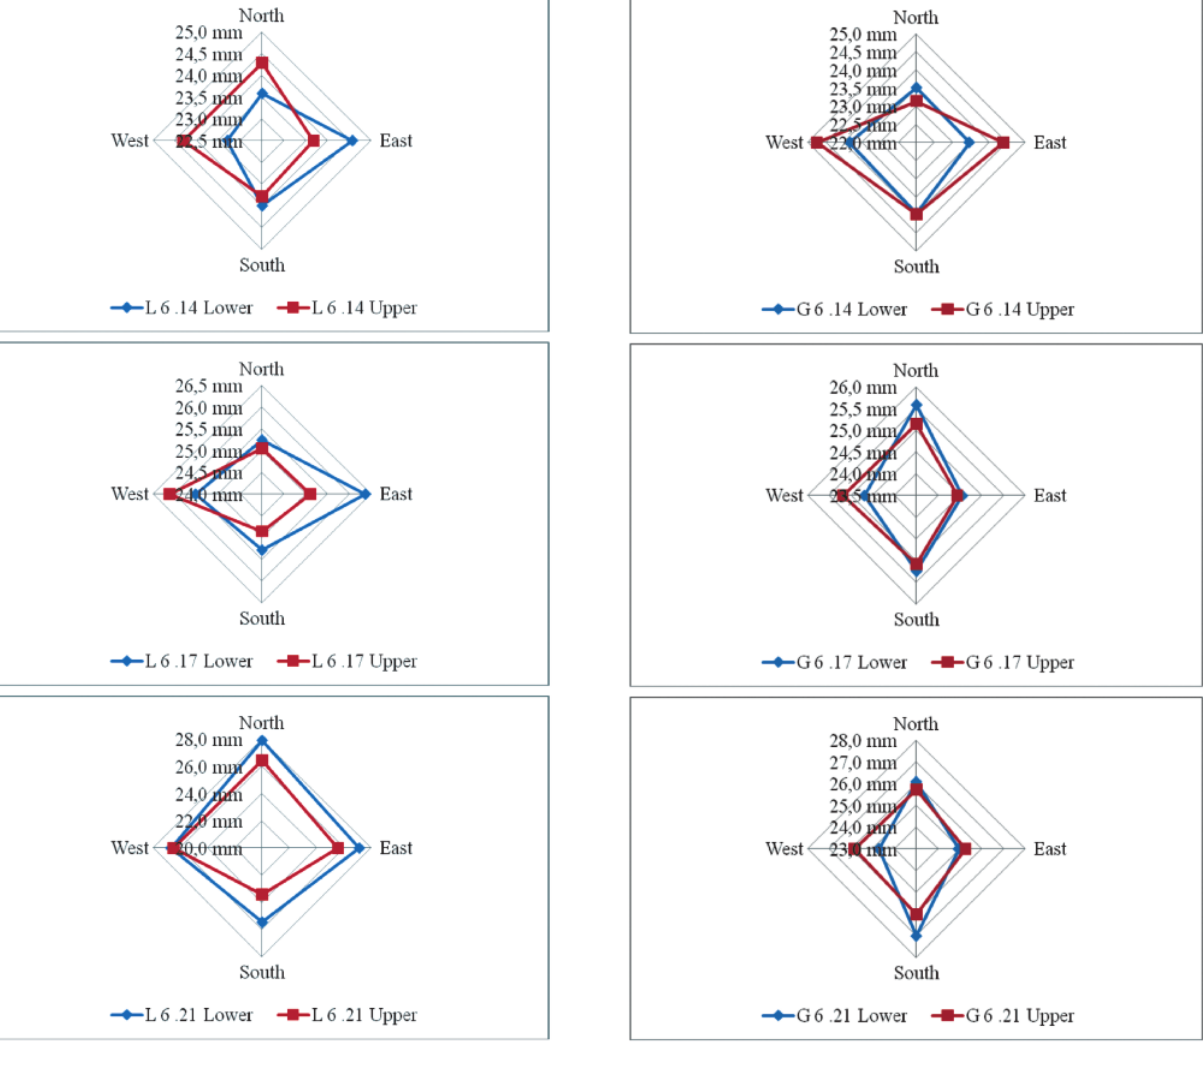
Fig. 3: The width in the function of time, orientation and height in the case of Linda [mm]